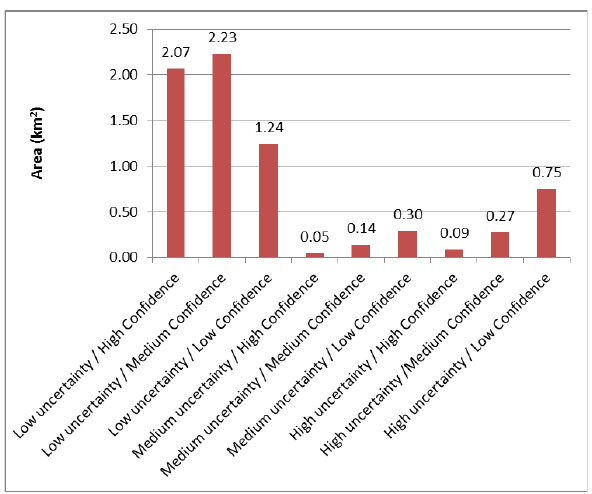
Figure 9. Area in km 2 of the region classified as Urban belonging simultaneously to the indicated levels of uncertainty and